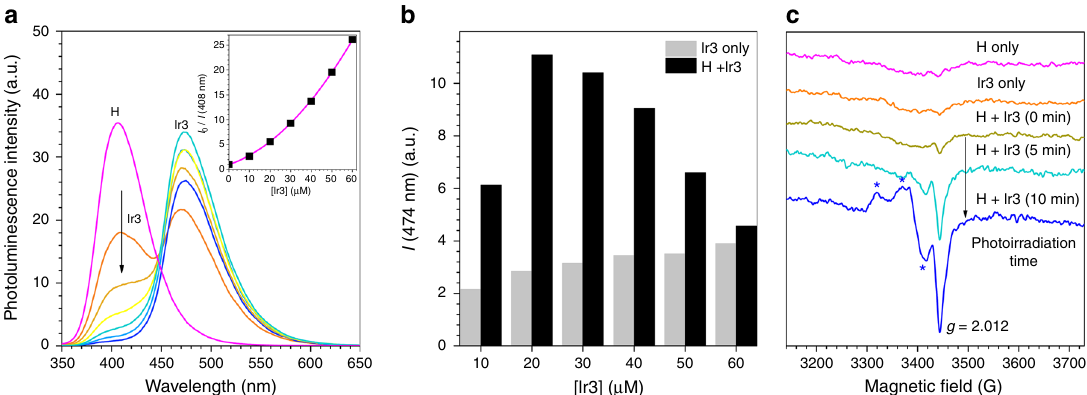
Fig. 3 Formation of radical ion pairs. a Photoluminescence spectra of 100 μ M H with added Ir3 (0 – 60 μ M). Photoexcitation wavelength used was 300 nm. The inset fi gure is a Stern – Volmer analysis of the fl uorescence of H in the absence ( I 0 ) and presence ( I ) of Ir3. The value of the intensity of the host fl uorescence was corrected by considering the absorbance of the dopant, following the relationship I = I and Abs 0 are the observed fl uorescence intensity, the absorbance at 300 nm in the presence of Ir3, and the absorbance at 300 nm in the absence of Ir3, respectively. The I 0 / I values were fi t to the Stern – Volmer equation I 0 / I = (1 + K a ·[Ir3]) × (1 + k q · τ 0 ·[Ir3]). In this equation, K a , k q , τ 0 , and [Ir3] are the association constant, the quenching constant, the fl uorescence lifetime in the absence of Ir3 (3.8 ns), and the molar concentration of Ir3, respectively. The Stern – Volmer analysis yielded k q and K a to be >10 12 M − 1 s − 1 and 6.8 × 10 3 M − 1 , respectively. The non-negligible contribution of the static quenching (i.e., the (1 + K a ·[Ir3]) term in the Stern – Volmer equation) may indicate the existence of excited-state interactions between H and Ir3. Stern – Volmer analyses for other Ir dopants are shown in Supplementary Fig. 2. b Phosphorescence intensities of 10, 20, 30, 40, 50, and 60 μ M Ir3 (deaerated THF) upon photoexcitation at 300 nm in the absence (gray bars) and presence (black bars) of equimolar concentrations of H. The decrease in the difference between the gray and black bars corresponded to the formation of radical ion pairs. c Photoinduced EPR spectra of Ar-saturated THF solutions of 1.0 mM H, 1.0 mM Ir3, and a mixture of 1.0 mM H and 1.0 mM Ir3 in the absence and presence of photoirradiation. Peaks marked with asterisks may correspond to the rhombic signals due to an Ir(IV) species of the radical cation of